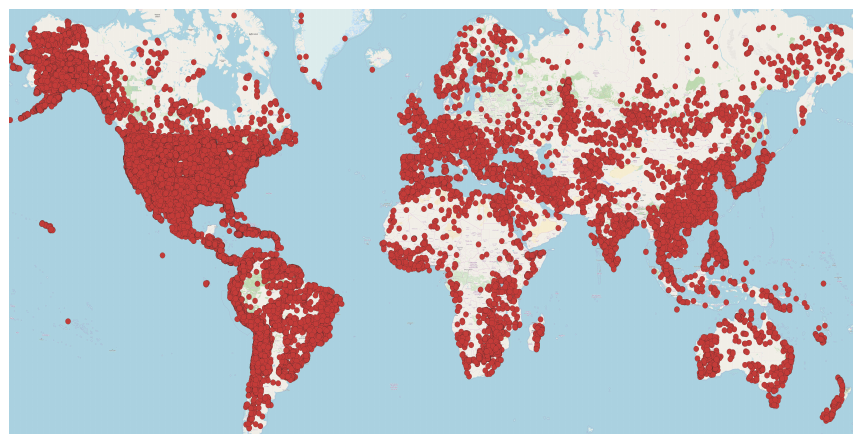
Figure 11. Cluster analysis with the aid of Density-Based Spatial Clustering of Applications with Noise (DBSCAN) clustering over the generated map.